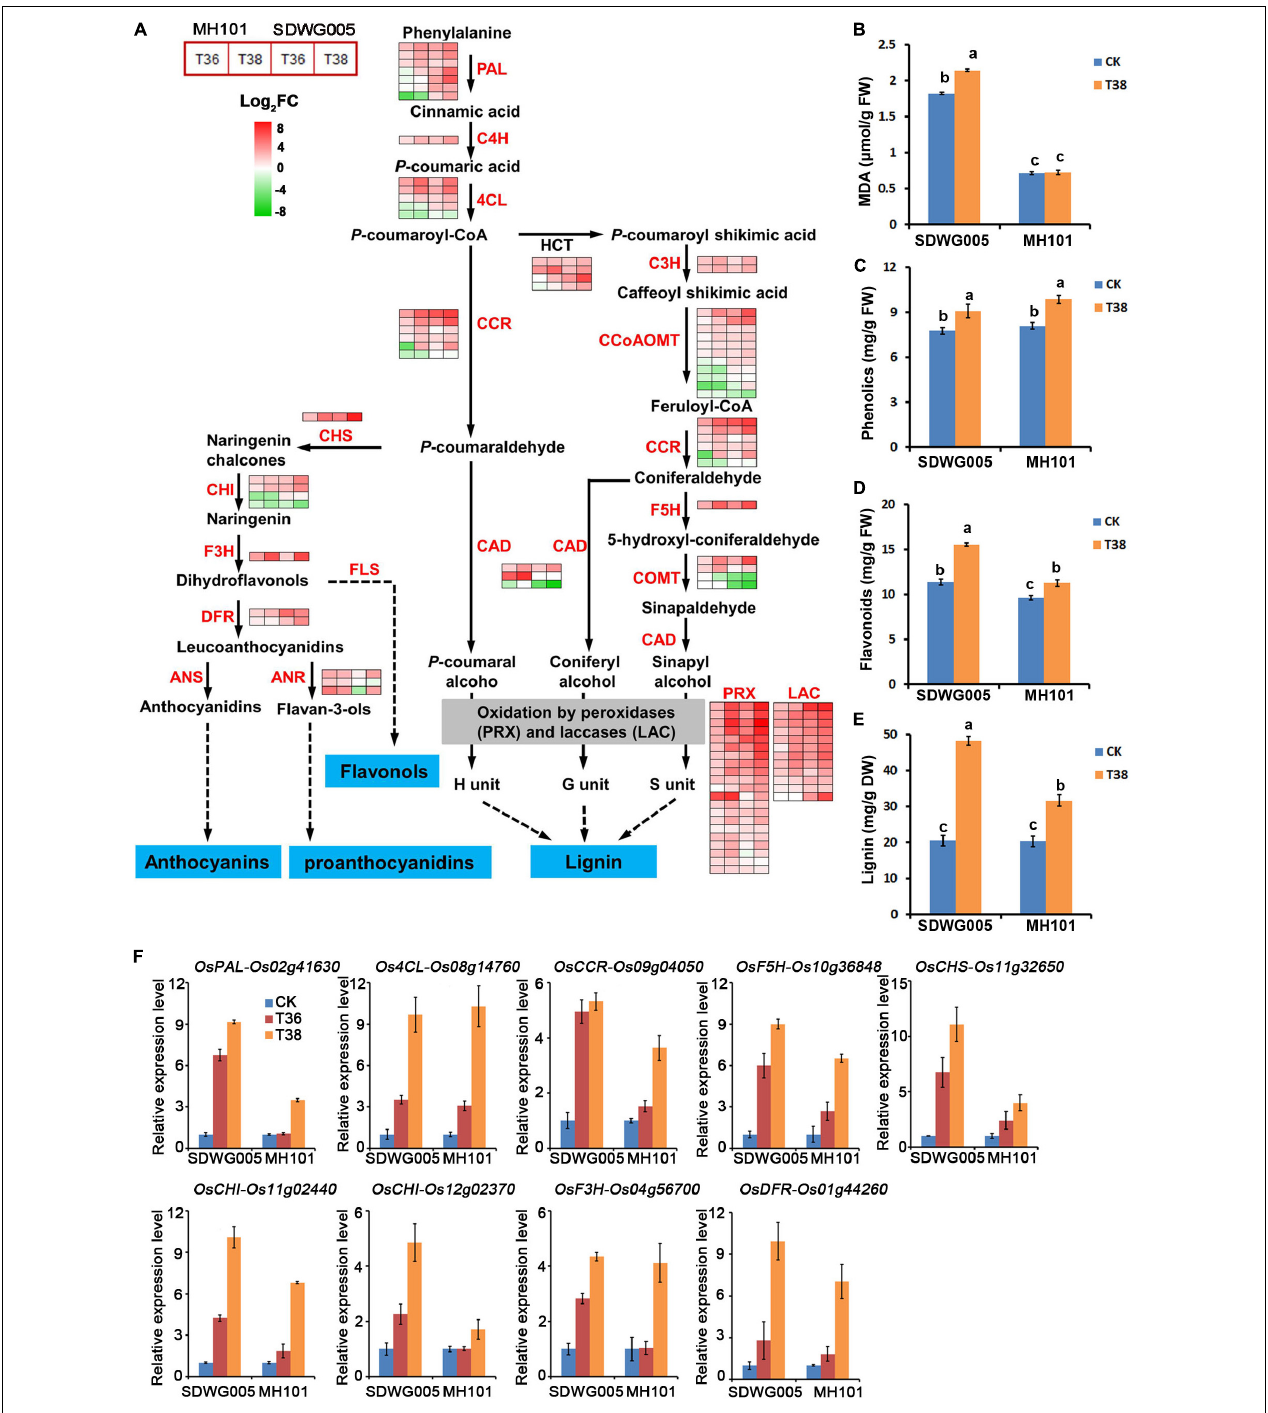
FIGURE 7 | Transcriptional changes of DEGs involved lignin and flavonoids biosynthetic pathways. (A) Expression heatmap of representative genes related to the lignin and flavonoids biosynthetic pathways. Data were log 2 transformed and normalized to those of the corresponding normal growth controls to determine fold changes, as indicated by the colored bar. The detailed expression patterns and identities of the genes in each of these biosynthetic pathways are shown in Supplementary Table S6 . Total content of MDA (B) , phenolics (C) , flavonoids (D) , and lignin (E) in spikelets of SDWG005 and MH101 varieties under heat treatment for three days. (F) The relative expression levels of OsPAL , Os4CL , OsCCR , OsF5H , OsCHS , OsCHI , OsF3H , and OsDFR in spikelets of SDWG005 and MH101 were determined by qRT-PCR under T36 or T38 conditions for three days. The O. sativa β -tubline gene was used for normalization. Each value represents the mean of three independent observations and SD determined. Significant differences were calculated by One-way ANOVA with Duncan’s multiple test (SAS Institute, Inc., Cary, NC, United States). Different letters indicate the statistical difference between samples at P = 0.05.